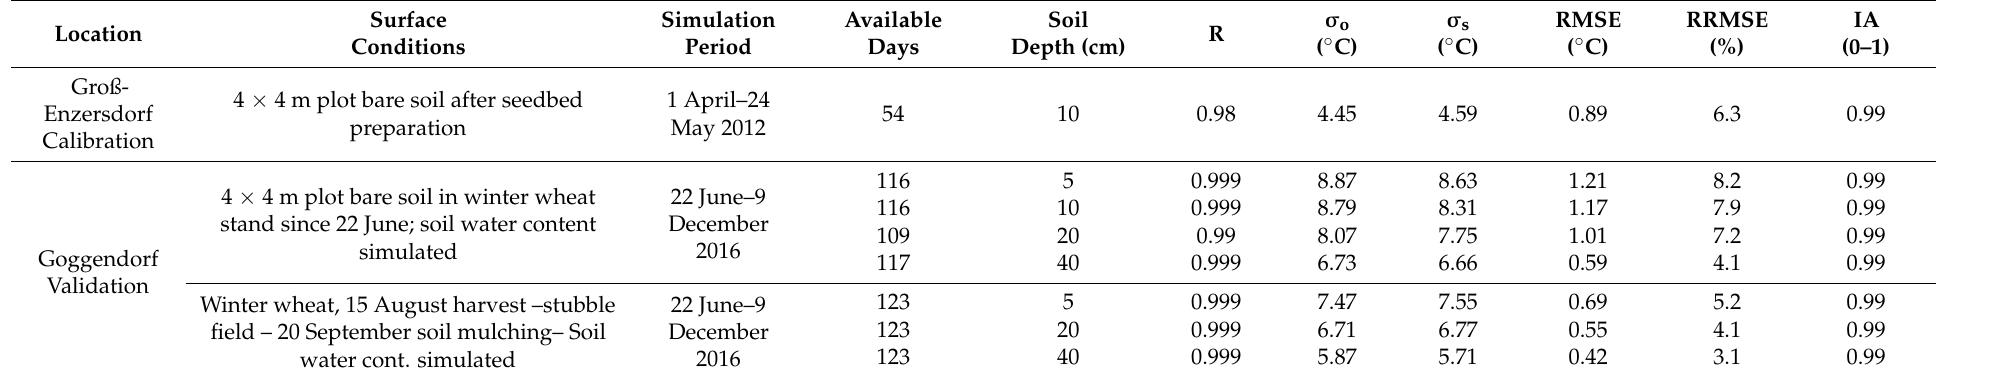
Table 4. Soil temperature model calibration/validation on study specific field